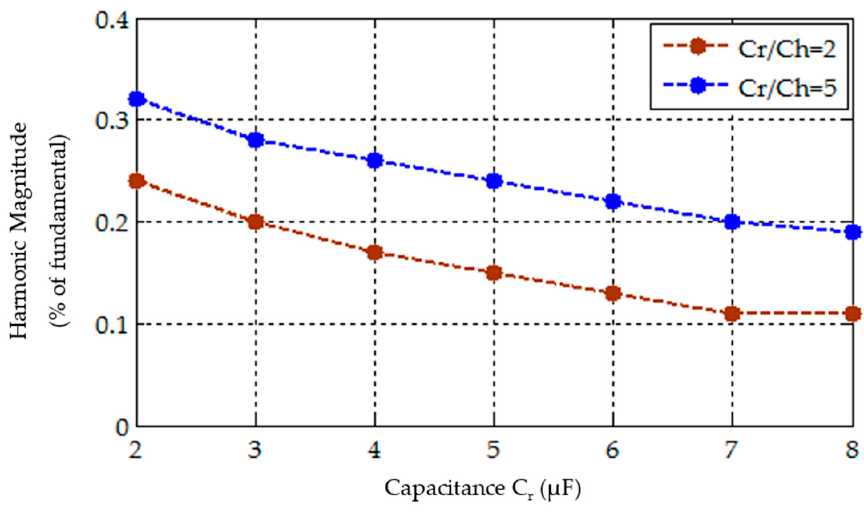
Figure 9. Harmonic variation with capacitance ratio.